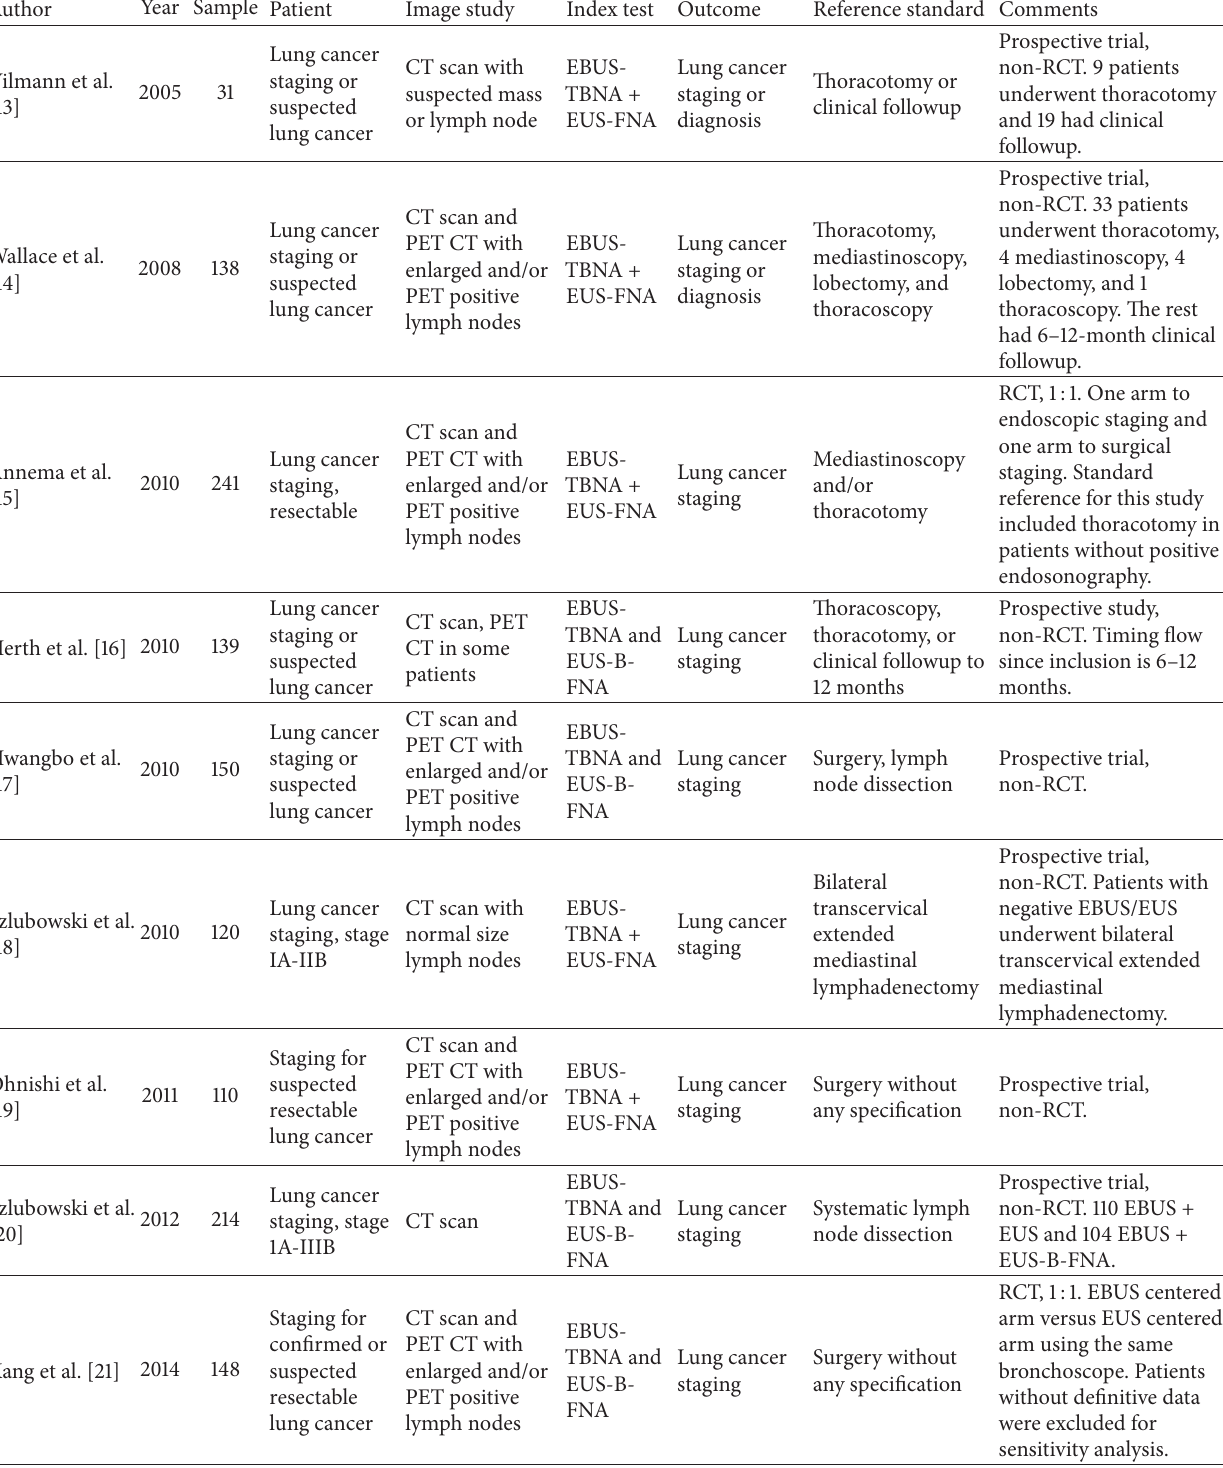
Table 1: Primary studies included and their